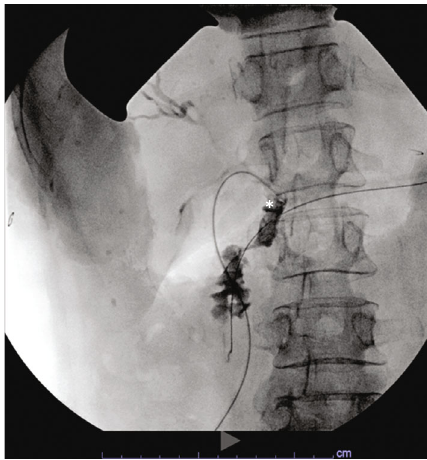
Figure 6: Intraop completion cholangiogram. It demonstrated good drainage with a patent CBD (marked by the asterisk).